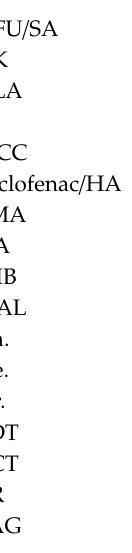
Figure S1: (a) Risk ratio for a participant to have all AK (100%) cleared for diclofenac / HA, (b) risk ratio for lesions to be cleared for the intervention ALA-PDT, and (c) risk ratio for a participant to withdraw from the study due to adverse events when treated with 5-fluorouracil solution 0.5% in combination with 10% salicylic acid (5-FU / SA). The forest plots show pooled data from single-armed studies (random-e ff ects analysis). The diamond represents the exact estimate from the study. The width of the line extending from each diamond represents the 95% confidence interval (CI); Table S1: Search strategy in the